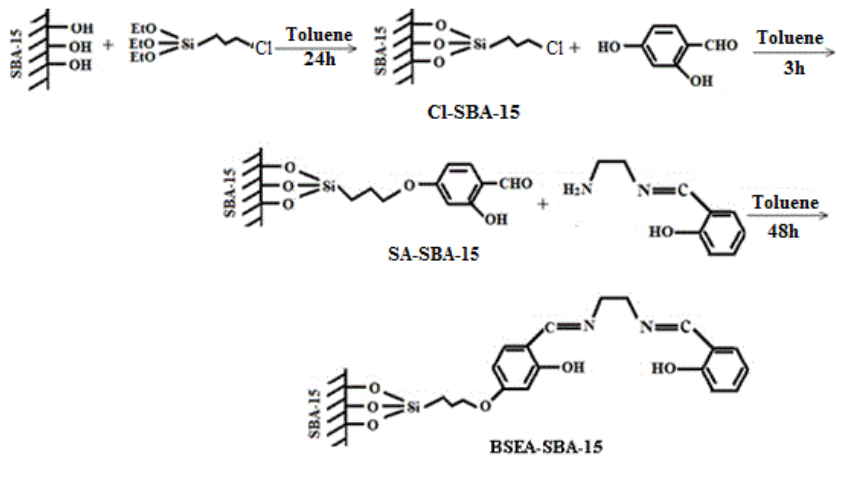
Scheme 1. The synthesis steps of